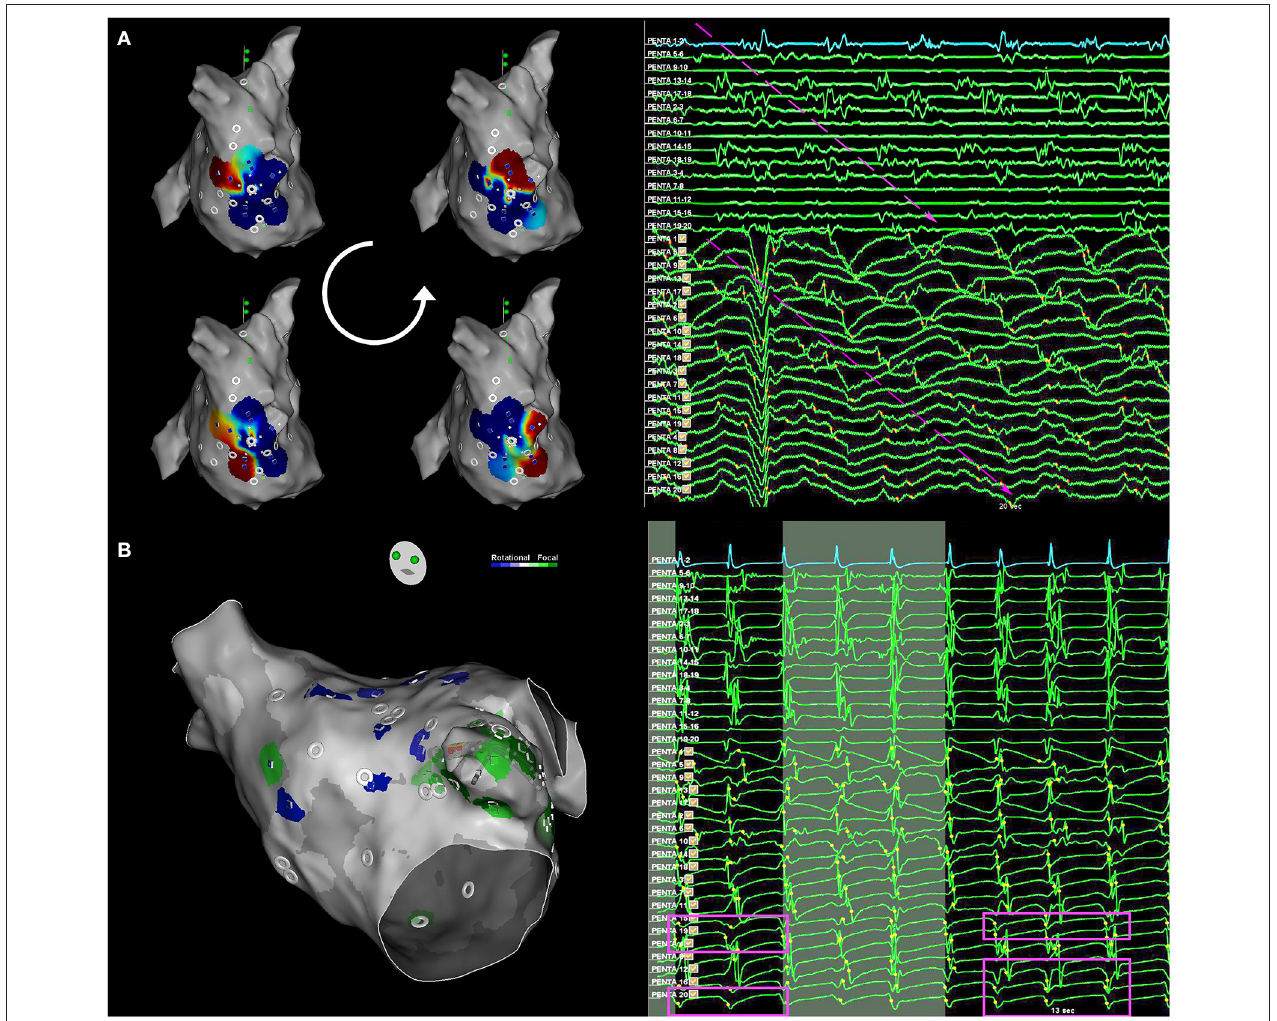
FIGURE 1 | Rotational and focal activity detection. (A) Rotational activity (RAc) detection with CartoFinder. Left, local activation map interactive view. One cycle of RAc is represented. Right, bipolar and unipolar EGMs from the multi-electrode catheter are shown. Electrograms (EGMs) are ordered by rings. Bipolar EGMs Penta 1–2 to Penta 17–18 form the external ring, Penta 2–3 to Penta 18–19 the middle ring, and Penta 3–4 to Penta 19-20 the internal ring. Unipolar EGMs Penta 1–17 form the external ring, Penta 2–18 form the external middle ring, Penta 3–19 form the internal middle ring, and Penta 4–20 form the internal ring. The staircase activation pattern expands the complete cycle. Long duration and low-amplitude EGMs are recorded by nearby electrodes: Penta 15–16, Penta 19–20, and Penta 18–19, where the center of rotation is located. The RAc has been highlighted by arrows. EGMs, electrograms. (B) Focal activity detection with CartoFinder. Left, the electroanatomical (EA) map view of the catheter was placed on the left atrial appendage. Focal activation is highlighted in green. Right, the darkest background window intervals show when repetitive focal activation events are detected with CartoFinder. The QS patterns are highlighted. Bipolar and unipolar EGMs are